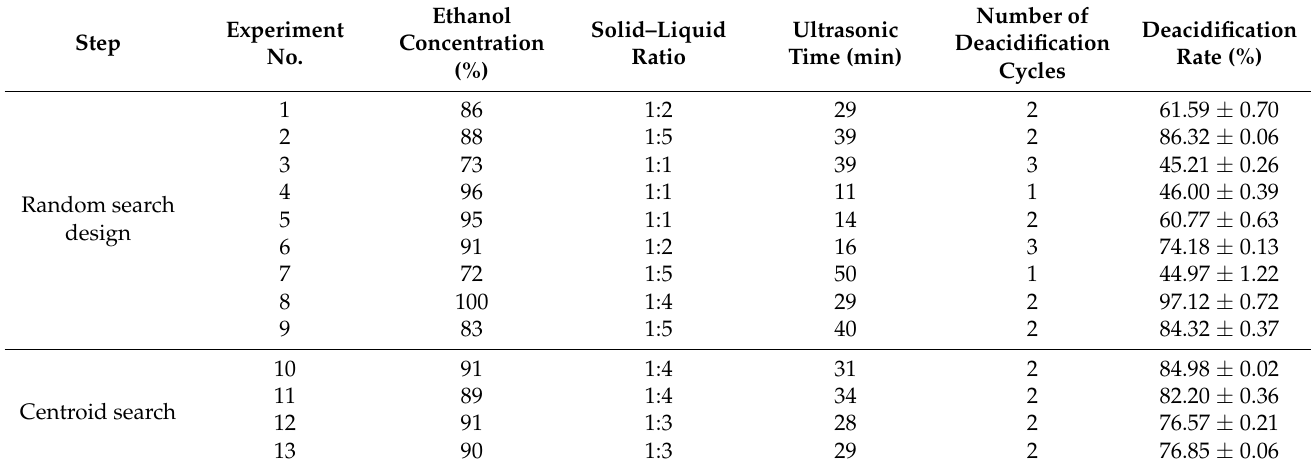
Table 1. Results of the first round of optimization